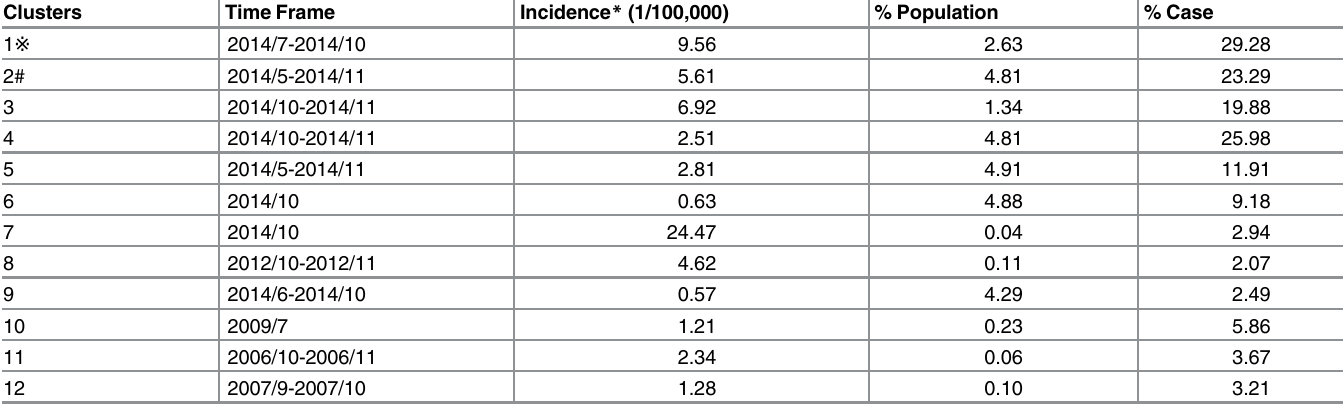
Table 4. Scrub typhus incidence rate, proportion of population and cases in spatiotemporal clusters detected using Kulldorff ’ s space-time scan statistic in mainland China, 2006 – 2014.